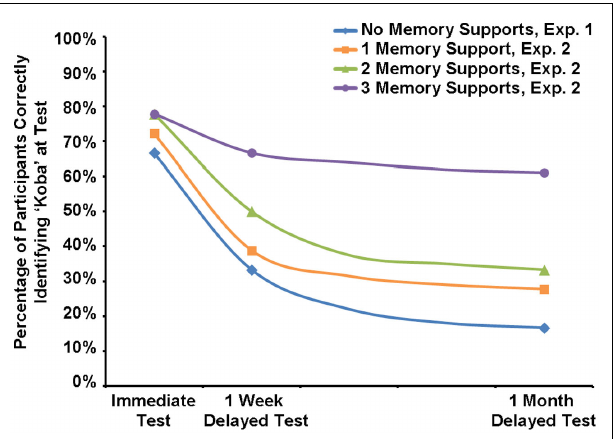
FIGURE 3 | Results of Experiment 2. The percentage of participants (children) correctly identifying the “koba” at the immediate test, 1week delayed test, and 1month delayed test, for four conditions of learning: no memory supports (from Experiment 1), one memory support (Experiment 2), two memory supports (Experiment 2), and three memory supports (Experiment